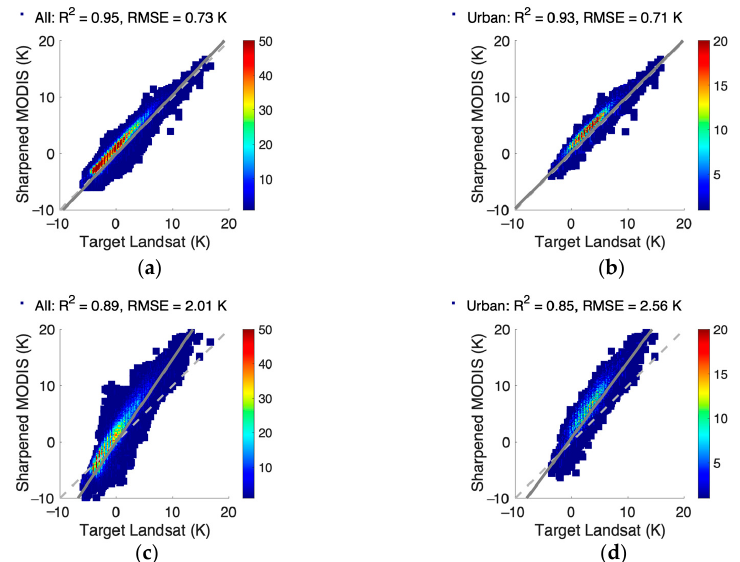
Figure 14. Pixel-by-pixel correlation between the target Landsat LST and the sharpened MODIS LST on 22 September 2016 for ( a ) the entire scene and ( b ) urban areas using our SS method. For comparison, the sharpening results with the Bilateral Filtering (BF) method are shown in ( c , d ). Color indicates data density, presented by number of pixels within each 0.1-K bin. The solid gray lines show the linear fitting functions and the dashed gray lines indicate the 1:1 relationship.